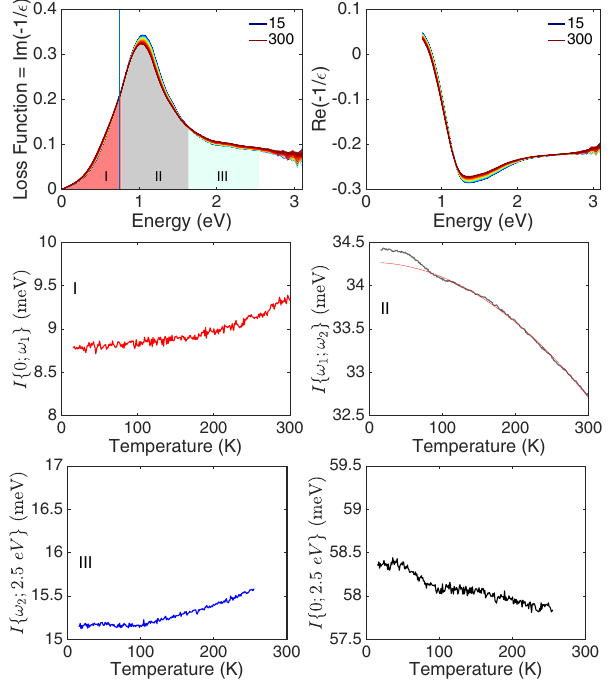
FIG. 9. Sample Bi2212-70-UD. Caption details as in Fig. 8. Because the signal for frequencies in zone 3 was not sufficiently stable above 256 K, the temperature range of the panels on the third line is limited below 256 K. The value of the fitted exponent α is 2.0.